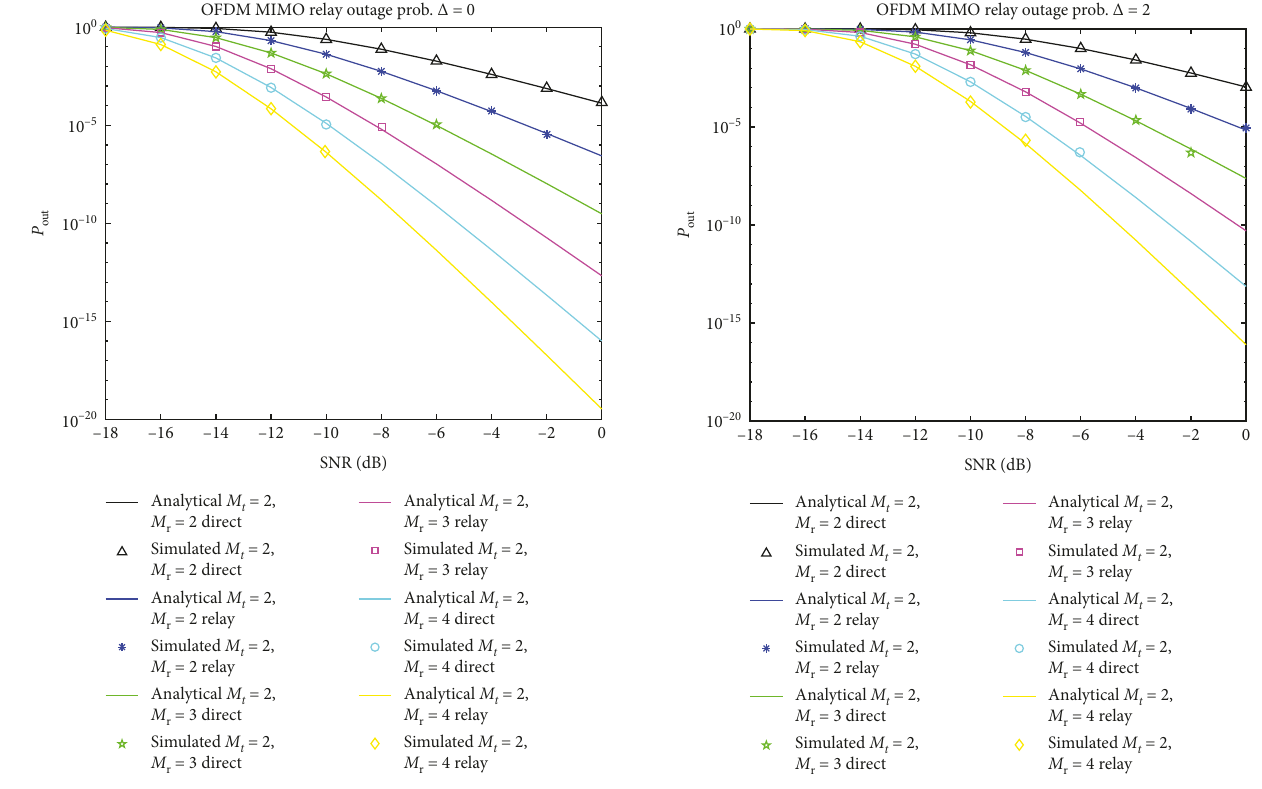
Figure 5: Outage probability with MIMO-OFDM direct and relay ( Δ � 2).